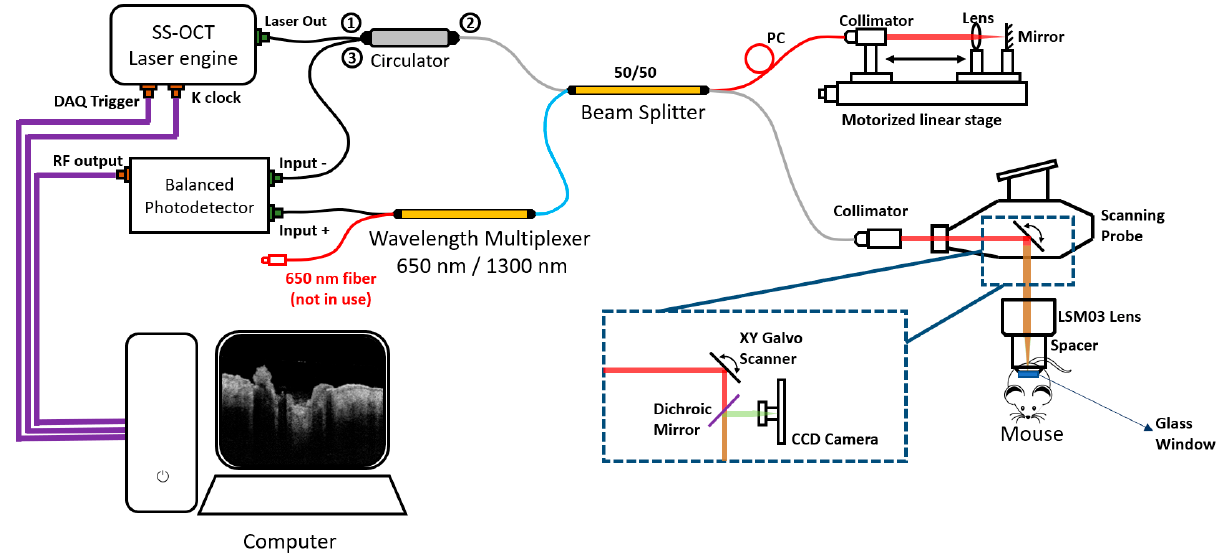
Figure 1. The diagram of the hand-held Swept Source OCT system used for pre-acquired datasets. “ ① ”, “ ② ”, and “ ③ ” close to “Circulator” are the Port 1, 2, and 3 of the circulator; CCD: charge-coupled device; PC: polarization controller.